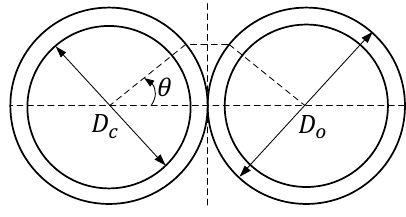
Figure 9. Two adjacent turns of the winding.